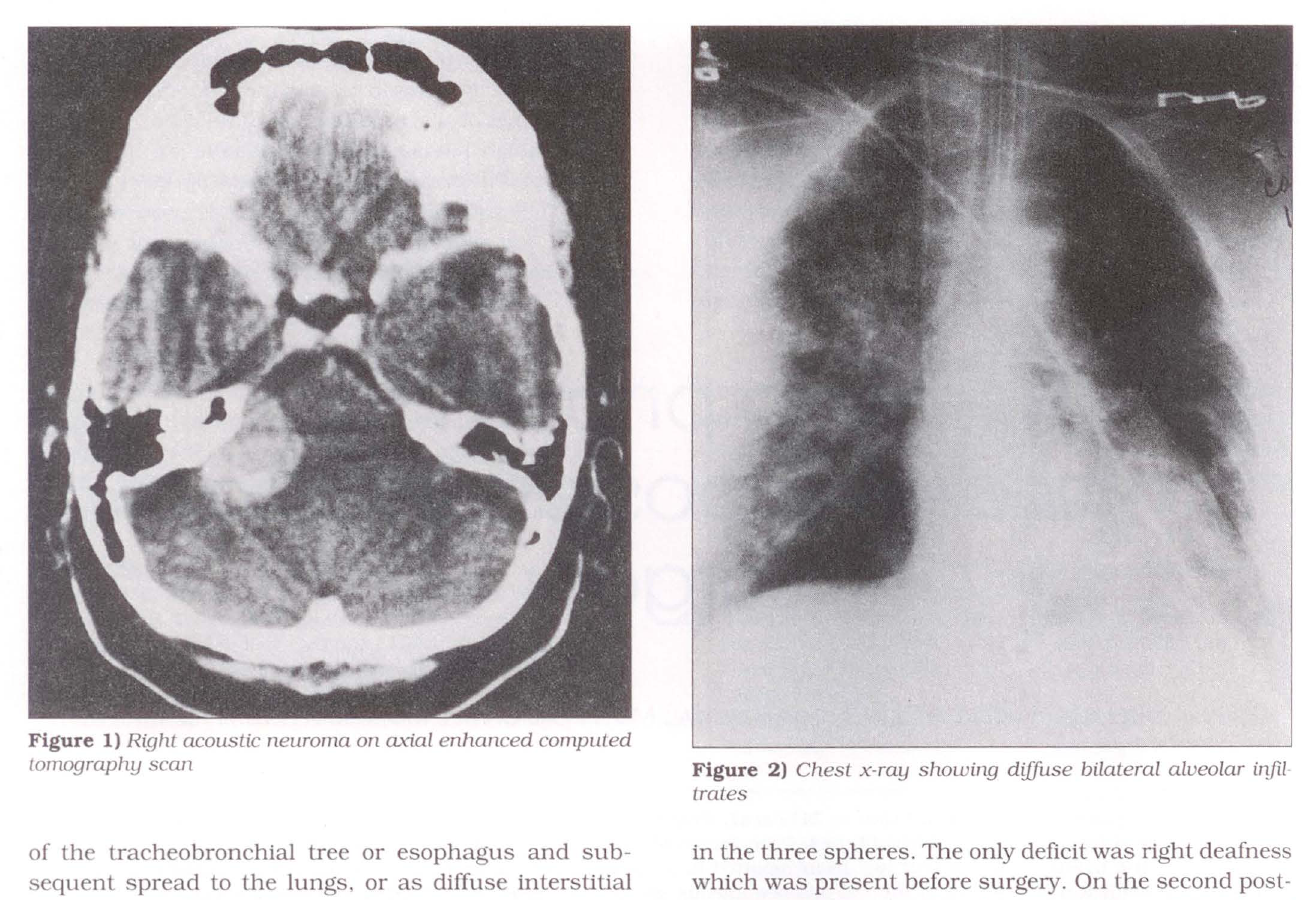
Figure 1) Right acoustic neuroma on axial enhanced computed tomography scan of the tracheobronchial tree or esophagus and sub